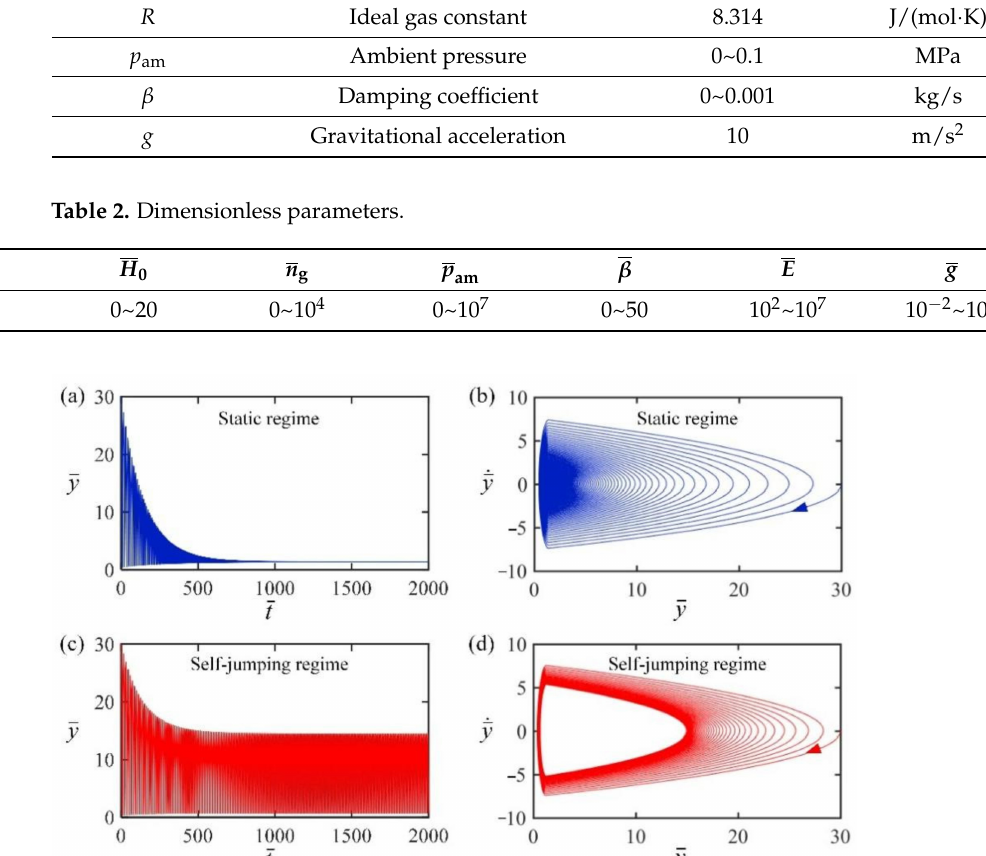
. = 0.5, g = 1, y = 30, and = 0. For the LCE y am 0 0